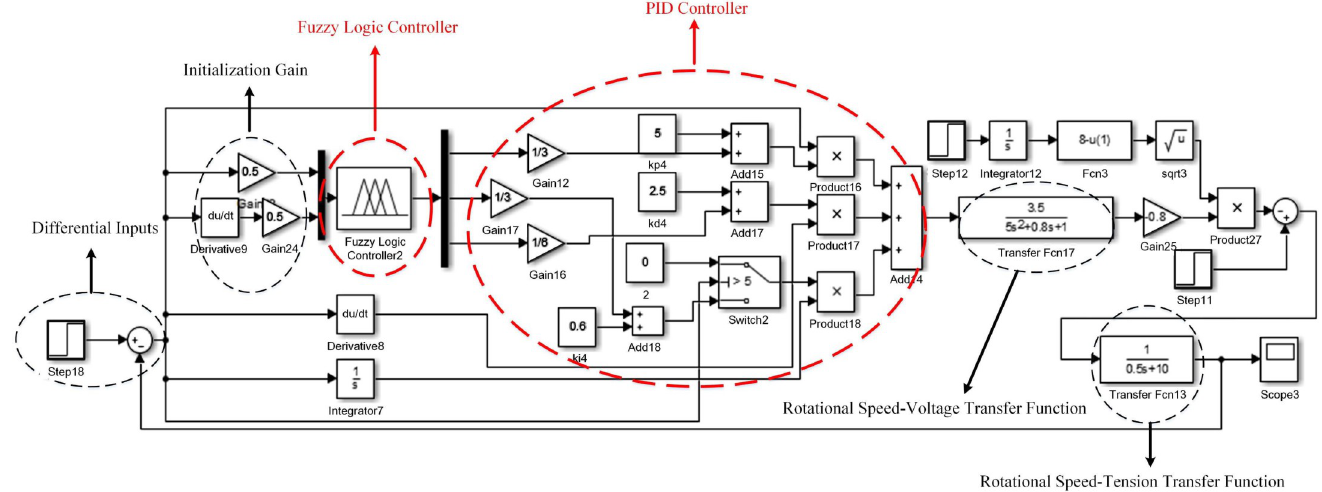
Fig 15. Fuzzy PID tension simulation